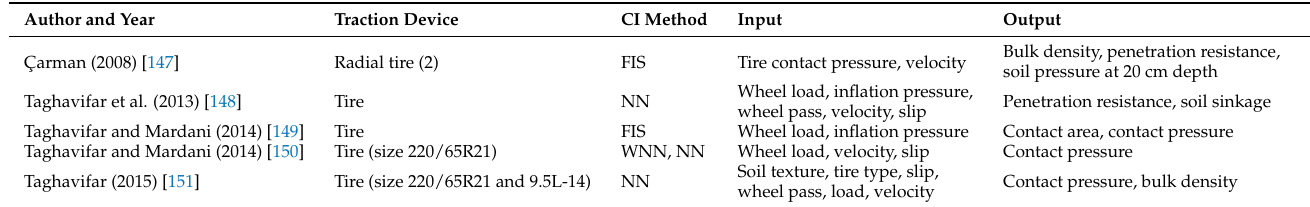
Table 3. Soil compaction studies that employed the CI methods.